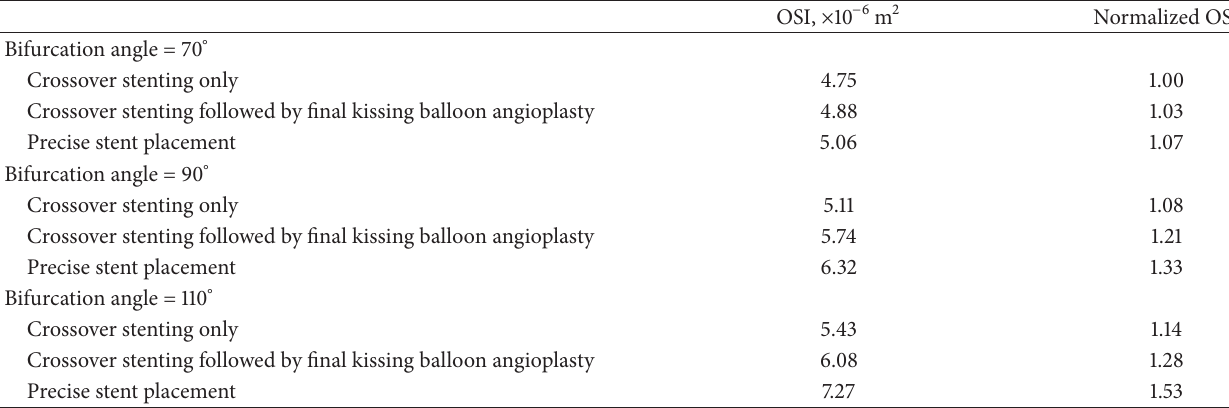
Table 2: Surface integrals of OSI for 3 considered stenting techniques under different bifurcation angle conditions.